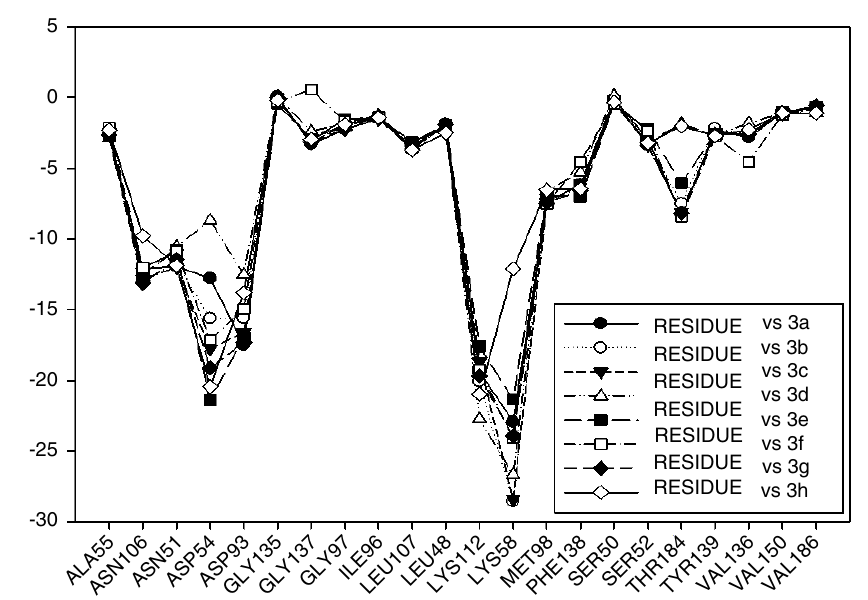
Figure 11. Interaction energies of 11-methoxy geldanamycin